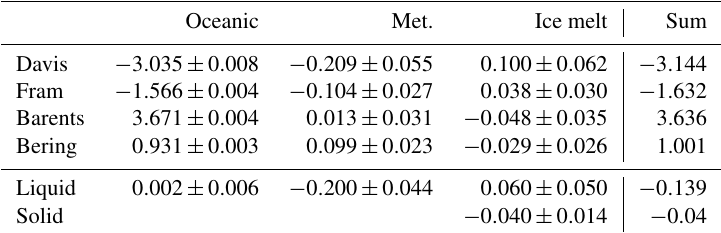
Table 4. Mean volume fluxes (Sv ± standard deviation) for the three-end-member (3EM) model. Positive values indicate fluxes into the Arctic. Values of solid freshwater flux from Tsubouchi et al. (2012). Oceanic Met. Ice melt Sum